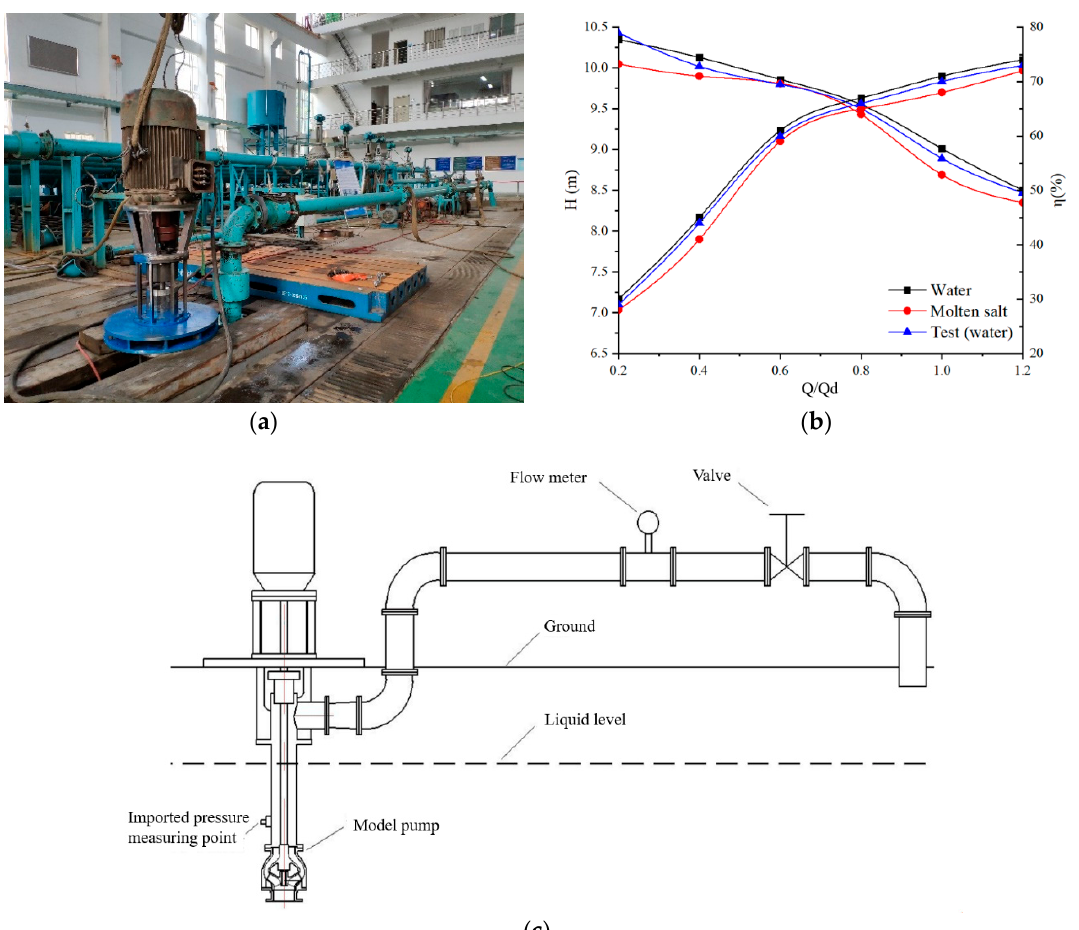
Figure 8. External characteristics of experiment results and simulation results. ( a ) Picture scene of experiment. ( b ) Comparison of simulation results and experiment results. ( c ) Test schematic.